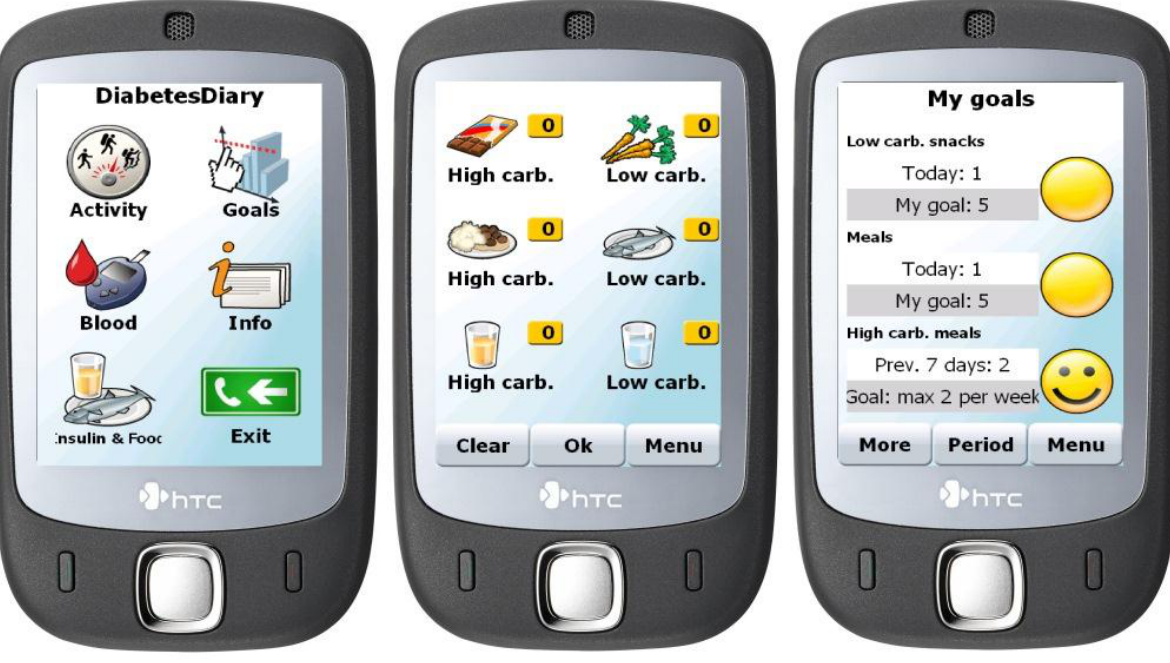
Figure 3. Few Touch Windows Mobile application screenshots showing the main menu (left), food registration (center), and feedback on diet goals